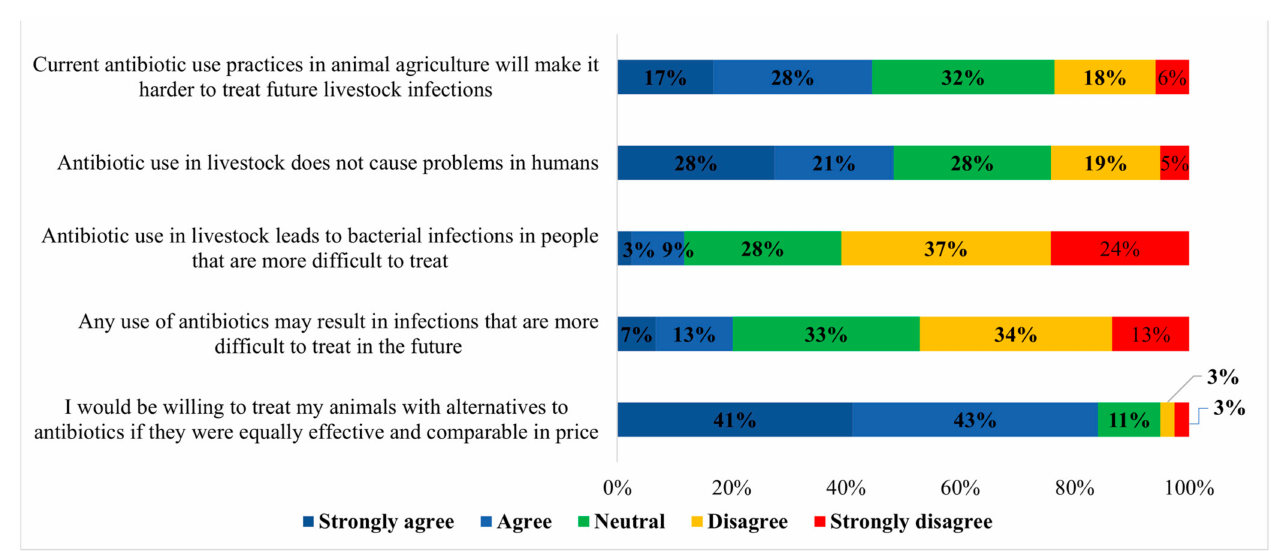
Figure 5. Findings of agreement level on statements related to antimicrobial resistance in dairy cows in California.